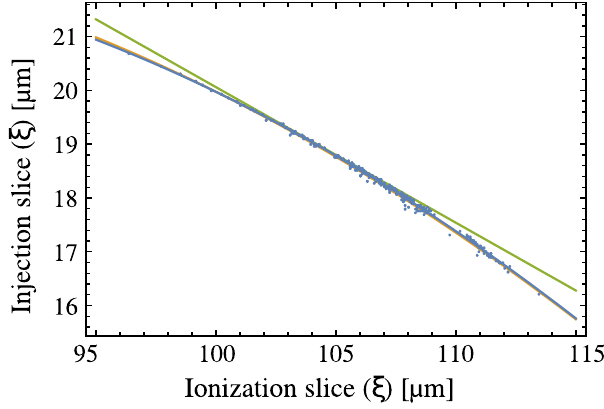
8. Plot of the injection relative location as a function of the ionization position of 500 selected electrons represented by the dots. Linear and quadratic fits to those electrons positions are shown by the green and blue lines. Yellow line is similar to blue line and is the result of the quadratic fit done with the weight information of each macroparticle (which depends on the probability of ionization when that particle was created). Propa- gation direction is from left to right side of the